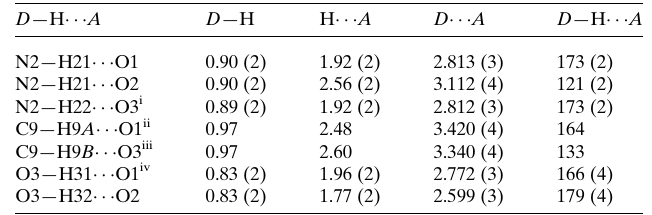
Table 5 Hydrogen-bond geometry (A˚ , (cid:5) ) for 6 .